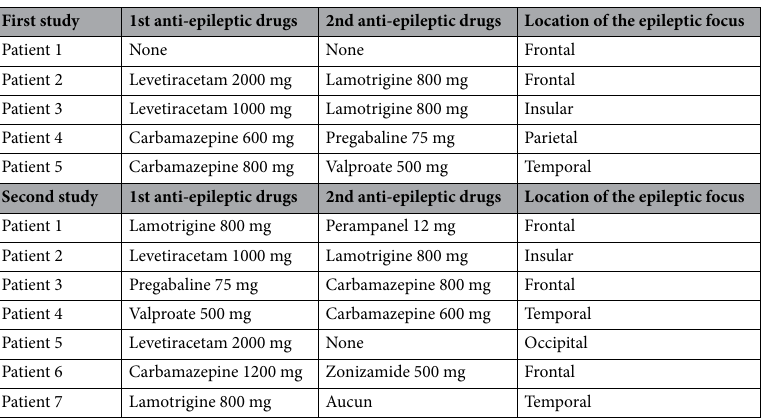
Table 1. Anti-epileptic drugs and location of epileptic foci of the patients of the two first